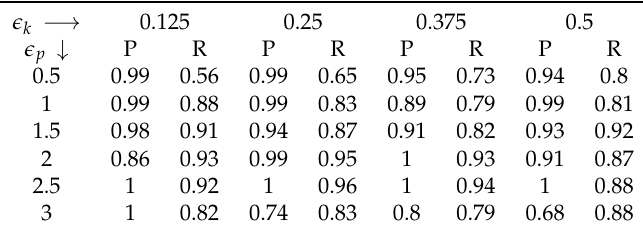
Figure 12. First frame segmentation for Scene 4. Table 6. Precision and Recall scores in Scene 4 using baseline method.